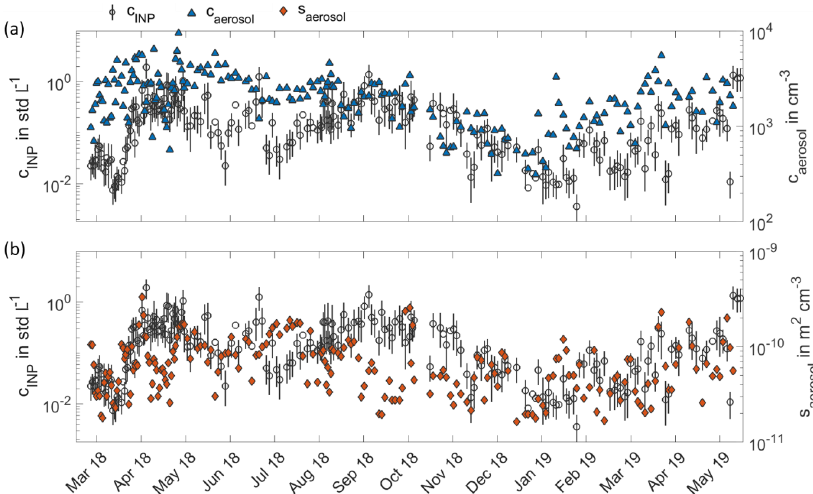
Figure A1. Time series of number and surface concentration of atmospheric PM 10 aerosol. Panel (a) shows the number concentration of atmospheric PM 10 aerosol particles measured by DMPS and APS (blue triangles) in comparison to the INP time series at 257K (circles) from 11 March 2018 to 31 May 2019. In panel (b) , the time series of PM 10 surface concentrations (orange diamonds) is compared to the INP time series for the same time period.